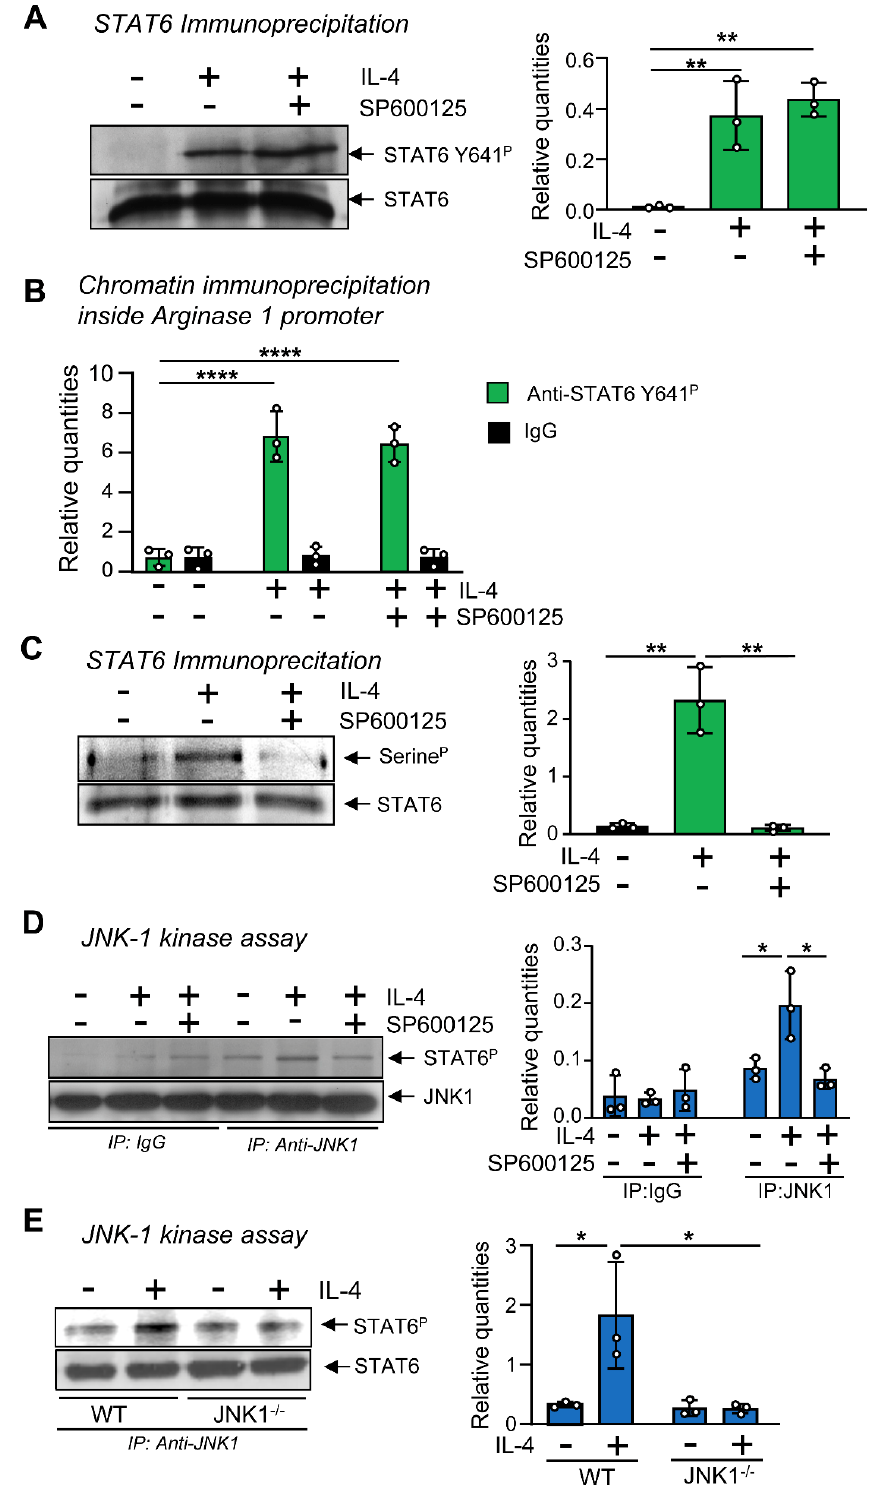
Figure 6. JNK-1 phosphorylates STAT-6 on serine without affecting its capacity to bind DNA. For A to C, macrophages were pretreated with the JNK inhibitor SP600125 (SP) for 1 h and then stimulated with IL-4 for 15 min. ( A ) Phosphorylation of STAT-6 (Y641) was analyzed by immunoprecipitation of STAT-6 and then via immunoblotting with an antibody, namely, either anti-phospho-Stat6 (Y641) or anti-STAT-6. ( B ) Chromatin immunoprecipitation assay (CHIP) was performed using the antibodies indicated. The presence of STAT6 Y641P in the Arginase 1 promoter was evaluated using